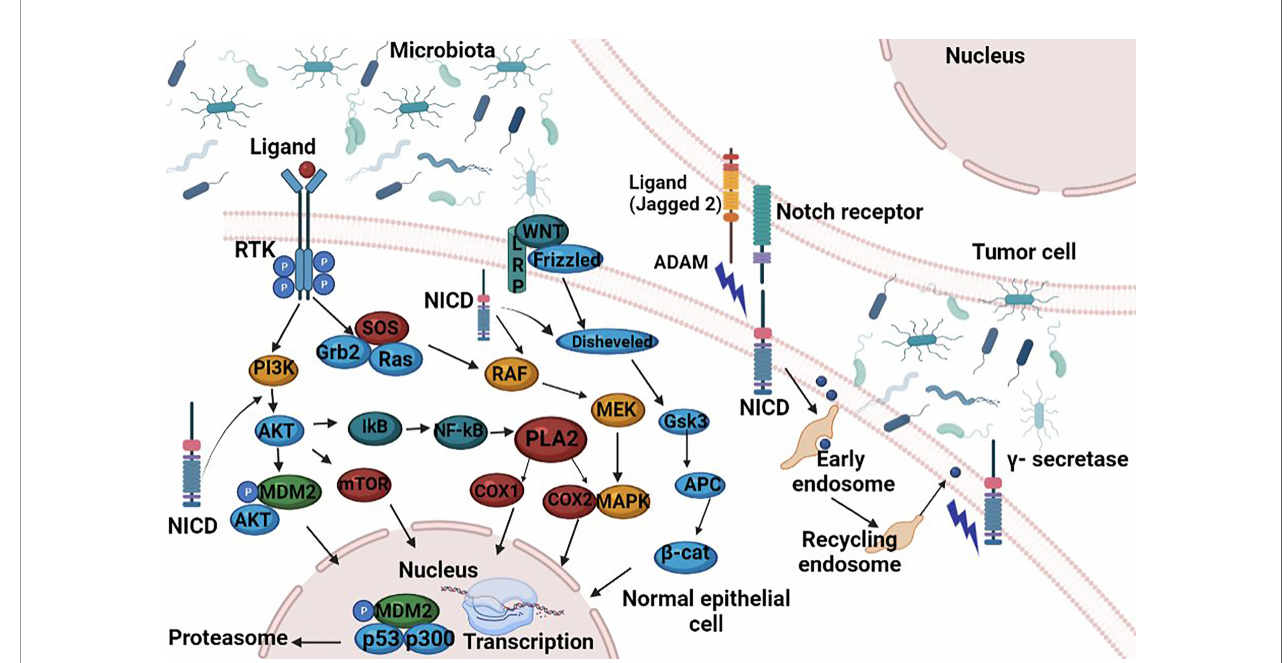
FIGURE 2 | Functional activities of b -catenin. (1) activation of the APC; (2) involvement of the APC in the E-catenin unit (ECCU); (3) activation of the b -catenin degradation site at the C-terminal end of the APC; (4) binding of the APC to the fi laments of tubulin; (5) binding of APC to DLG/EB1 proteins. When b -catenin accumulates in the cytosol, the Wnt signalling pathway is inhibited and GSK3 b signalling pathway is activated. Active GSK3 b simultaneously phosphorylates b - catenin and APC, which it also activates. The APC phosphorylation is possible only if Axin protein is included in the b -catenin-GSK3 b -APC assembly also. Once activated, the APC protein is capable to bind free cytoplasmatic b -catenin. APC, “ adenomatous polyposis coli ” ; GSH3 b , glycogen synthase kinase 3 b ; DLG and EB1, tumor suppressor proteins; CRD, cysteine-rich domain; Frzb, Frizzby protein; Frizzled, Wnt protein receptor; Dsh, Dishevelled protein; DLG, protein “ human large disc ” ; EB1, protein EB1. Figure created in